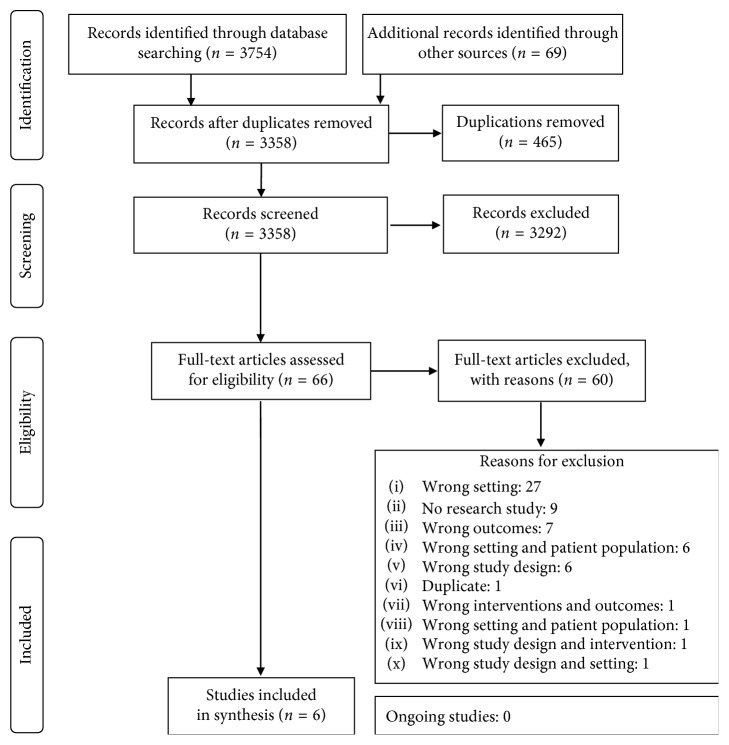
Flow diagram of the study selection.